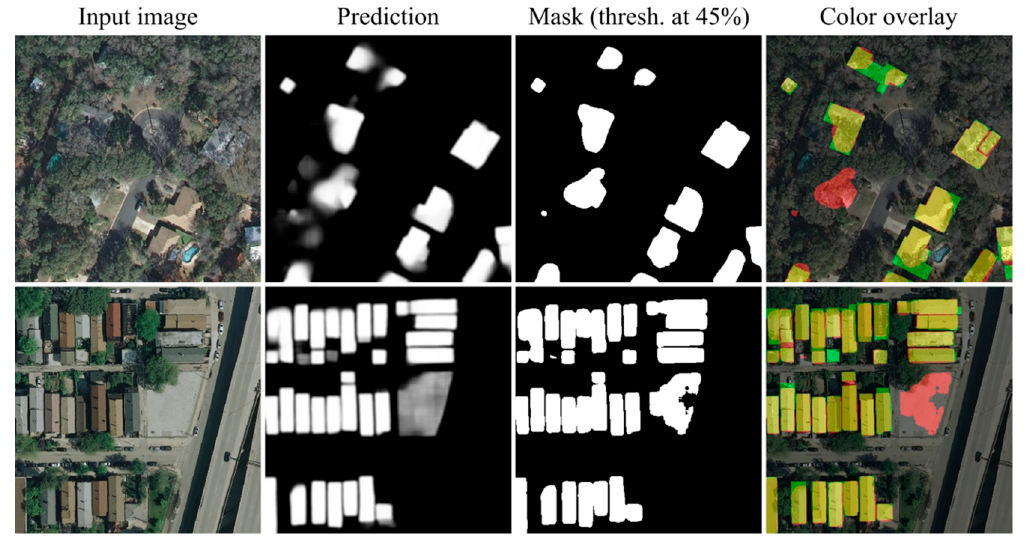
Figure 13. Examples of segmentation errors. The color overlay shows the obtained mask in red and the ground truth in green, resulting in a yellow overlay where those two overlaps.